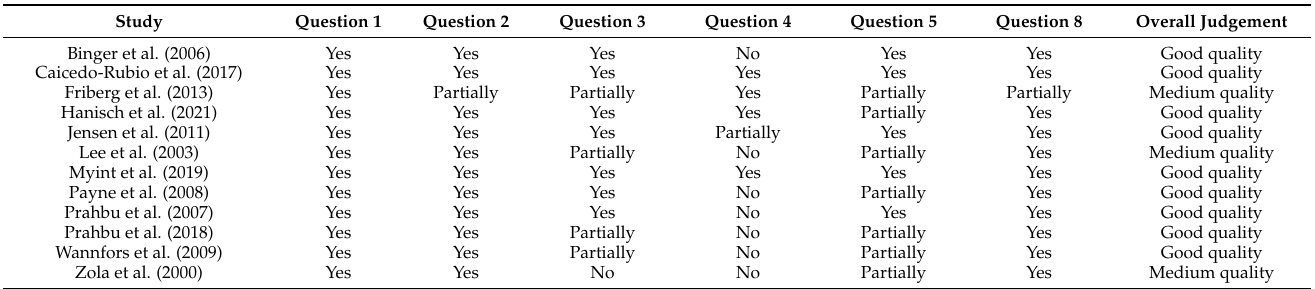
Table 3. Results of the quality assessment using the tool for Methodological Quality and Synthesis of Case Series and Case